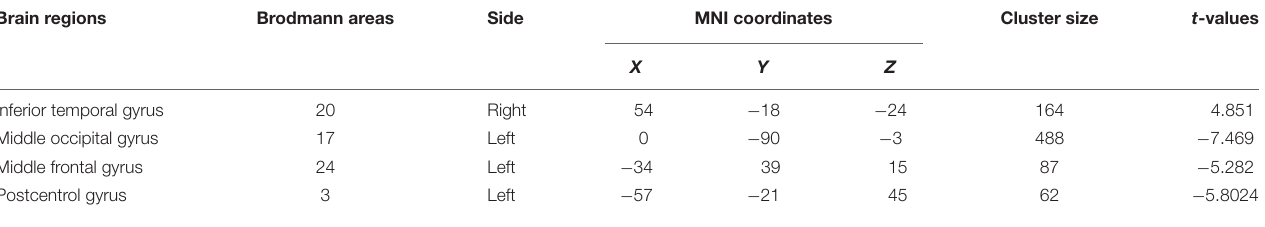
TABLE 5 | Brain regions in ReHo between MDD and healthy controls. Brain